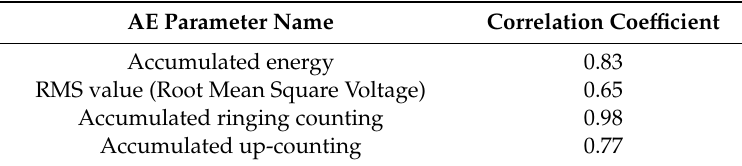
Table 1. Correlation coefficients between AE parameters and DFRH after monthly average. AE: acoustic emission, DFRH: daily fluctuation of relative humidity.